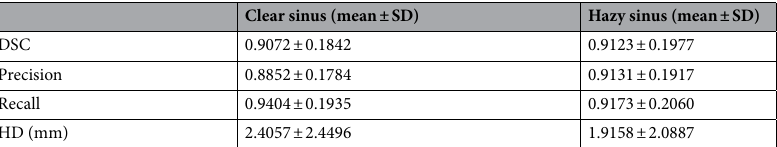
Table 3. Final AI prediction results after post-processing according to sinus condition. AI artificial intelligence, DSC dice similarity coefficient, HD Hausdorff distance, SD standard